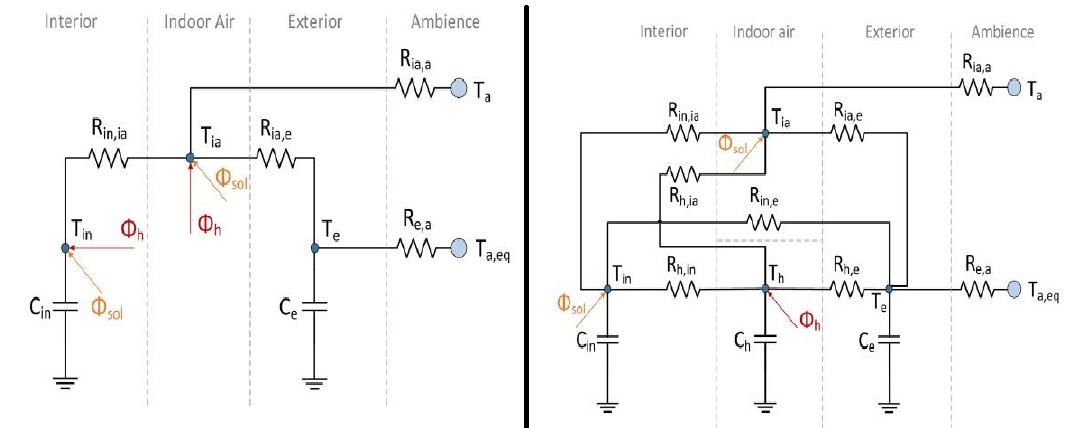
Figure 7. Building thermal structures—4R2C and 8R3C